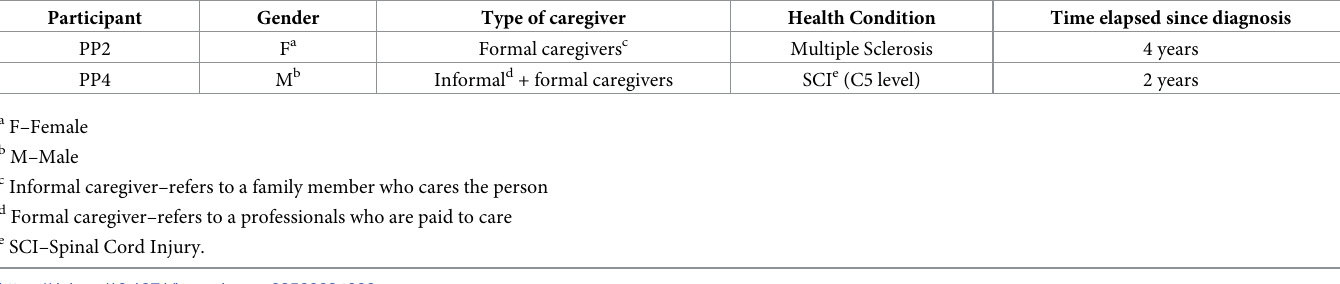
Table 8. Data of participants who did not use the system.